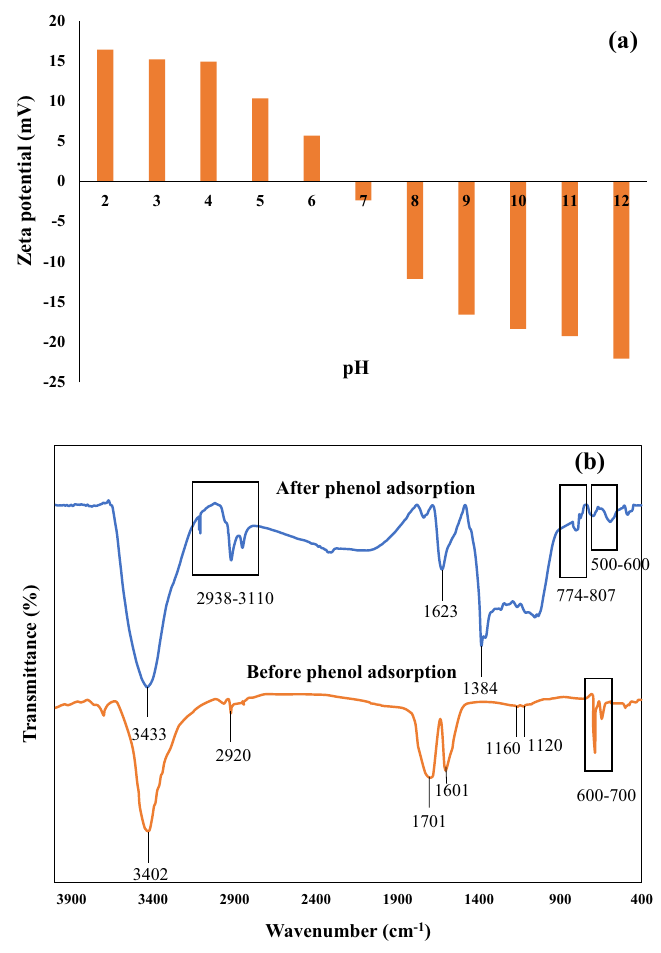
Figure 1. ( a ) Zeta potential and ( b ) FTIR spectra (transmitance mode) of MSAC composite before and after phenol adsorption (T = 25